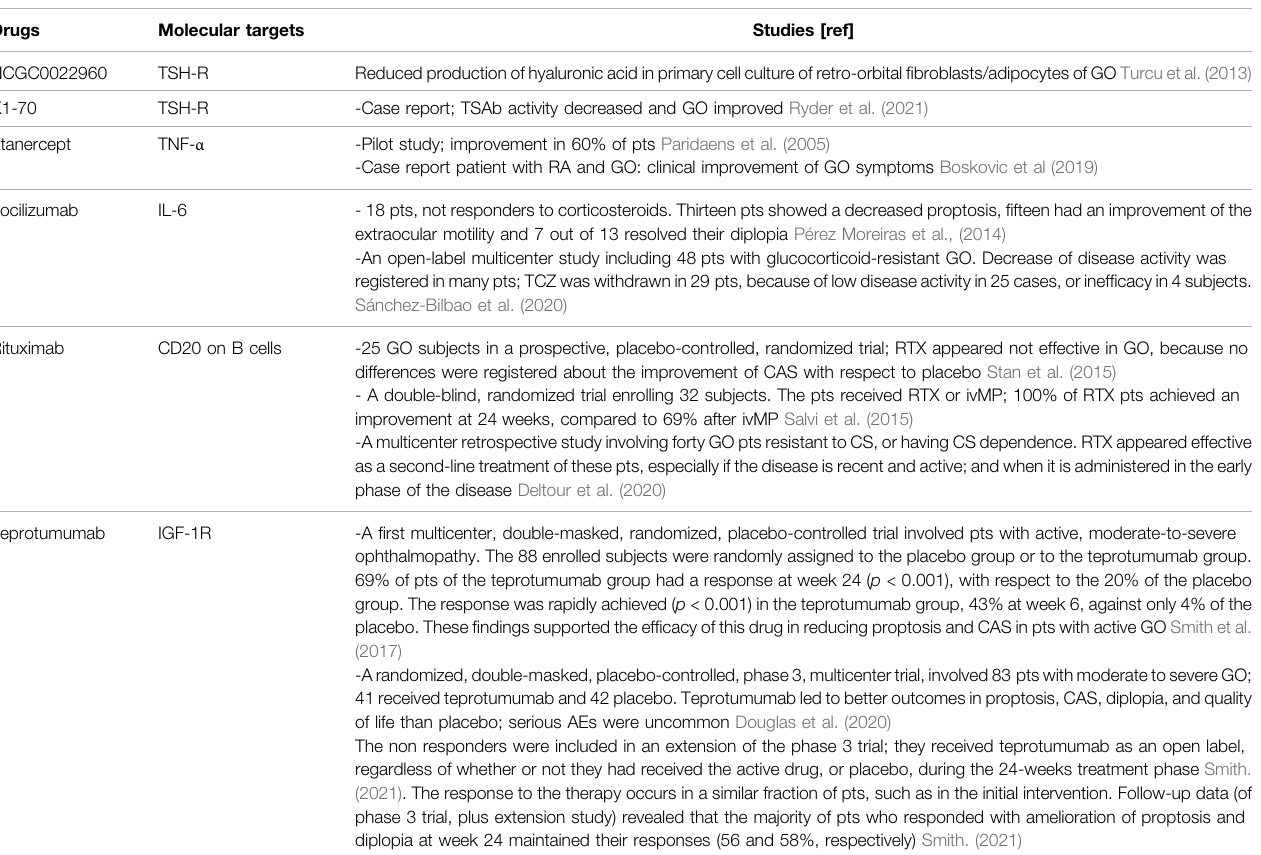
TABLE 2 | Latest drugs for Graves ’ Ophtalmopathy. Drugs Molecular